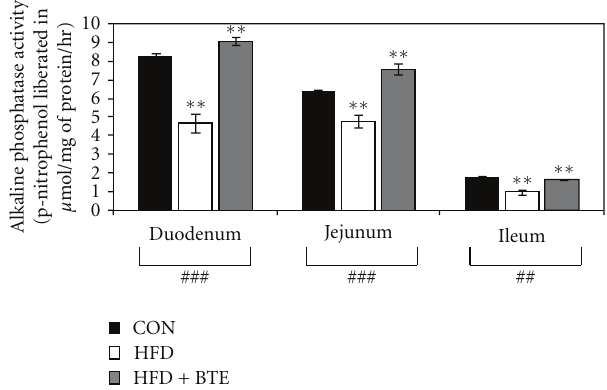
Figure 6: Alkaline phosphatase activity of intestinal mucosal extracts in duodenal, jejunal, and ileal segments of control (CON; Group A), HFD treated (Group B), and HFD + BTE supplemented (Group C) groups of rats. Values are expressed as mean ± S.E.M. ( n = 6). ### and ## denote significance level P < . 001 and P < . 01, respectively, based on Kruskal-Wallis nonparametric ANOVA test and ∗∗ P < . 01 denotes significance level based on Mann-Whitney “U” multiple comparison